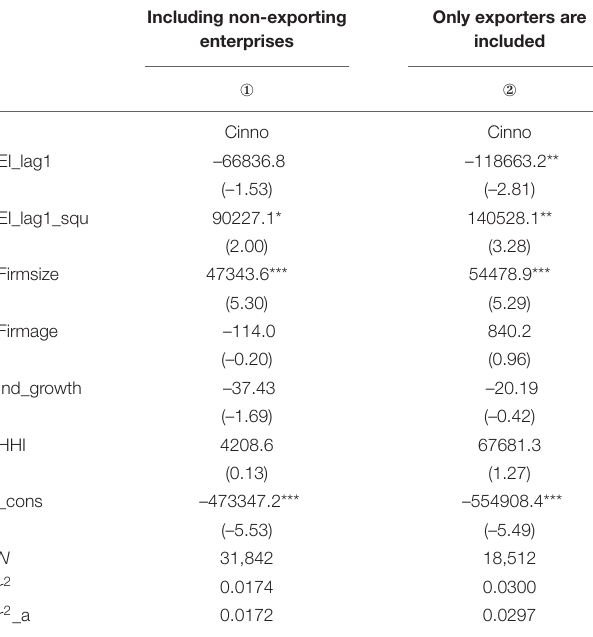
TABLE 4 | Results of instrumental variables analysis. TABLE 5 | The results of U-shaped relationship between export and innovation with added control